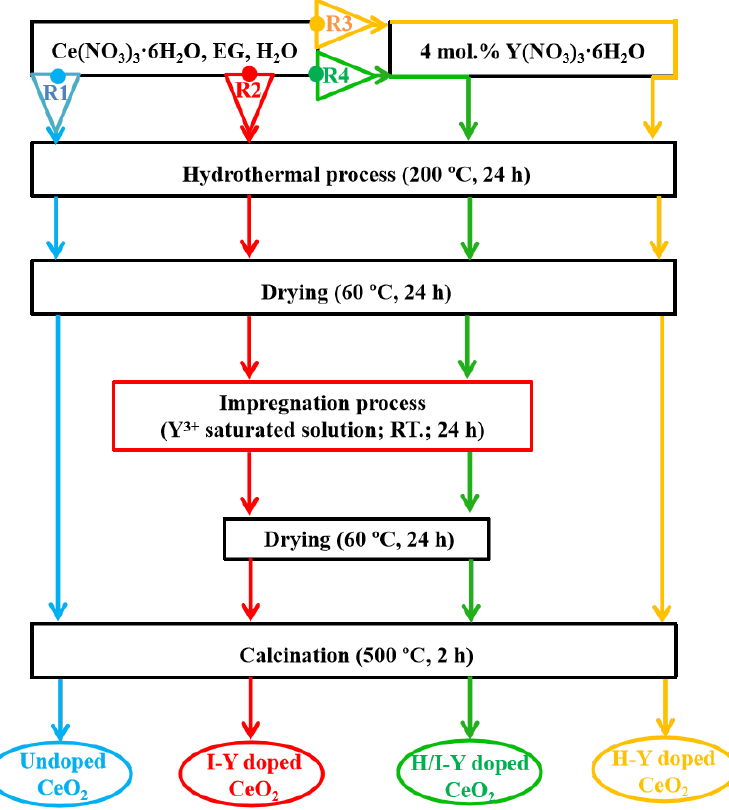
Figure 1. Schematic illustration of the synthesis of undoped and Y-doped CeO 2 using three routes.